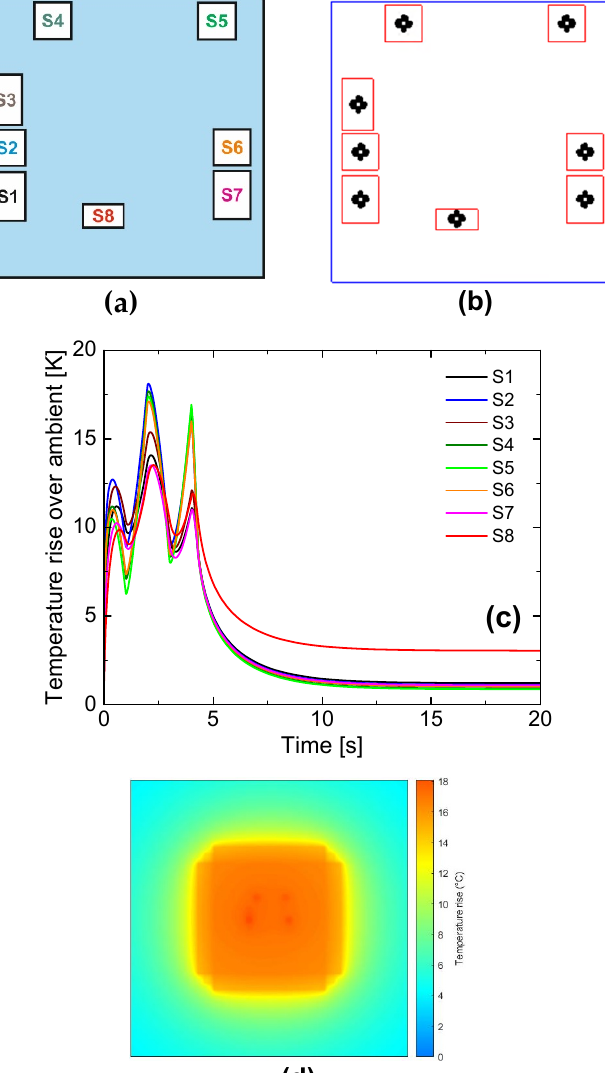
Figure 14. ( a ) Schematic top-view of the die floorplan; ( b ) corresponding TRIC interface; ( c ) evolution of the temperature rises vs. time; ( d ) temperature rise map at the time instant t = 2.5 s.